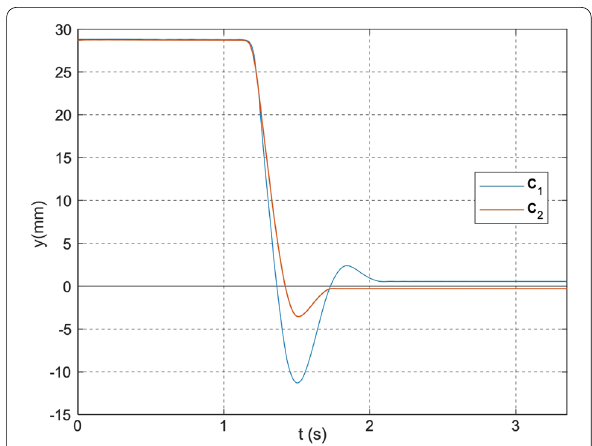
Fig. 1 Experimental results of impedance control on a Panda robot. The responses are performed with an initial displacement in the y direction, released with zero initial speed, corresponding the damping matrices of C 1 and C 2 , respectively